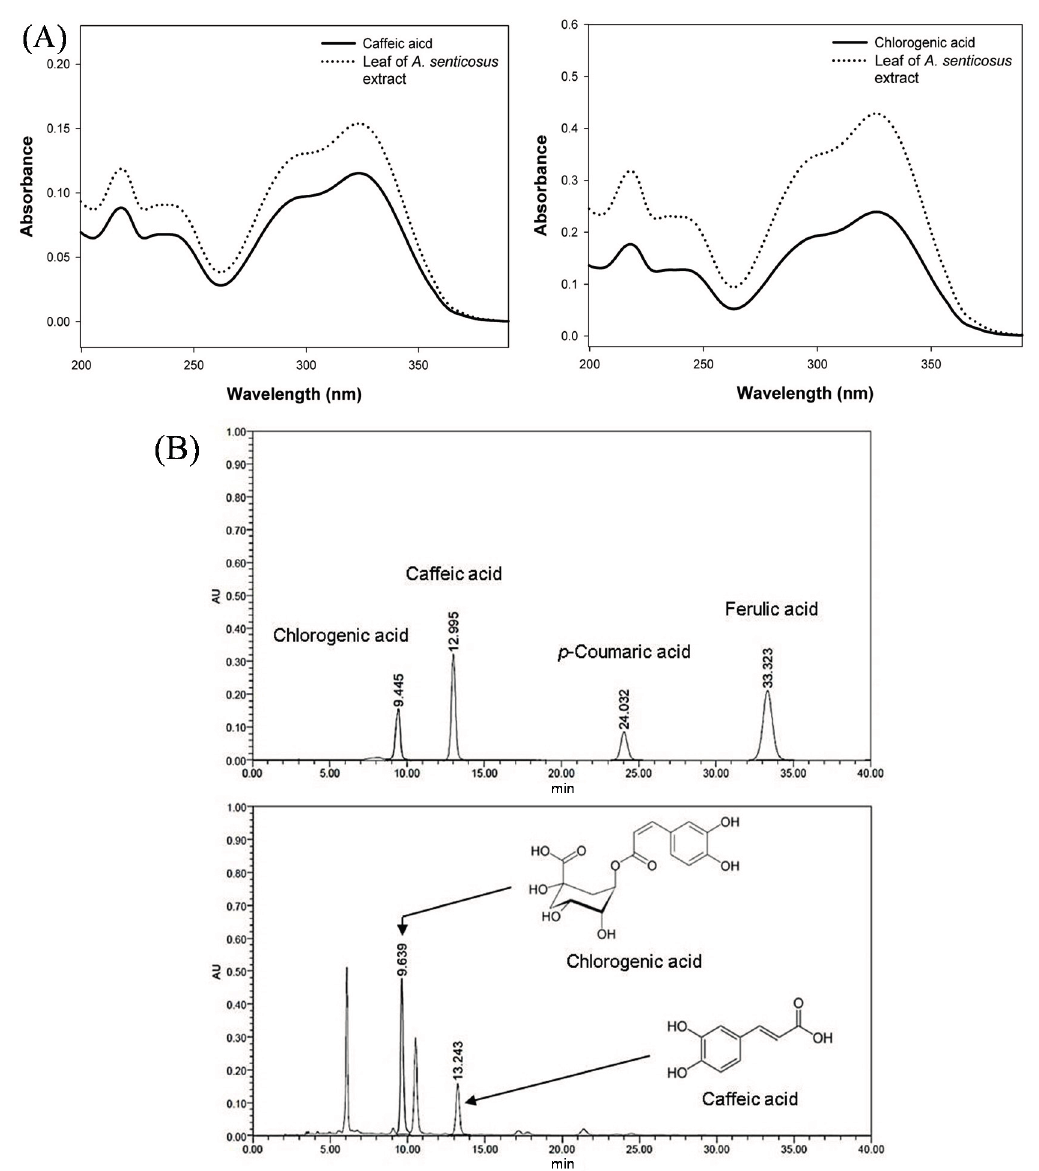
Figure 2. PDA spectrums of caffeic acid and chlorogenic acid ( A ); and HPLC chromatograms of phenolic compounds (chlorogenic acid, caffeic acid, p -coumaric acid, and ferulic acid) ( B ) of leaf extract from A.